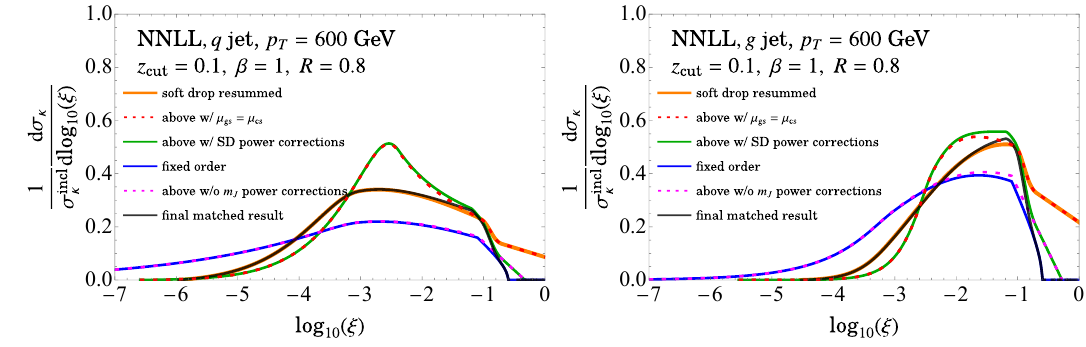
Figure 2 . The matched curves at NNLL for quark jets (left) and gluon jets (right). The dotted curves correspond to overlap terms that are subtracted in the matched cross